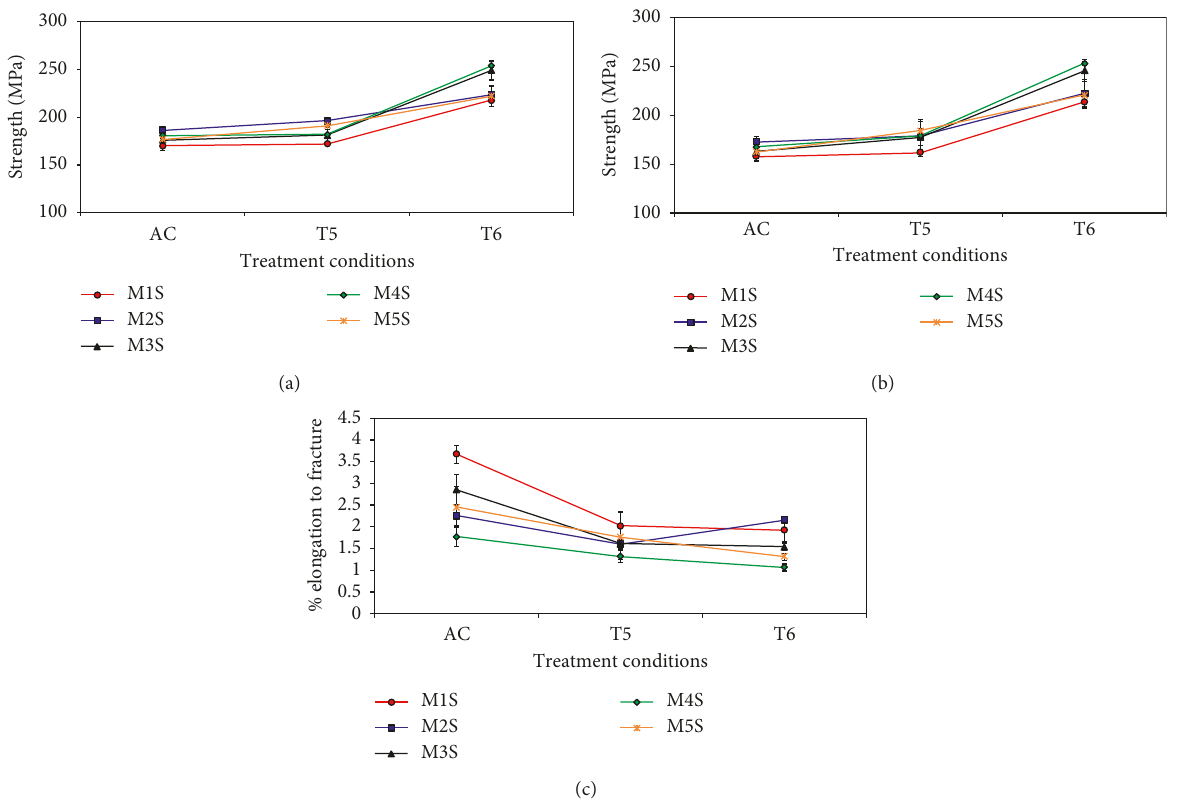
Figure 5: Variation in average (a) UTS, (b) YS, and (c) % El values of the alloys studied in the as-cast, solution heat-treated (SHT), and T5- and T6-treated conditions obtained at 250 °